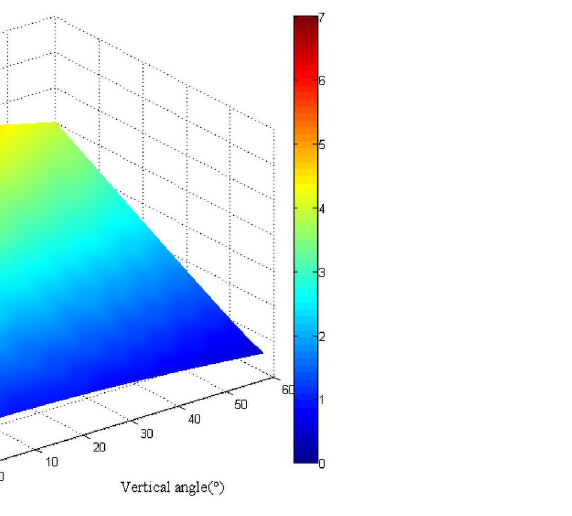
Fig 4. Plane displacement accuracy with the polar coordinate